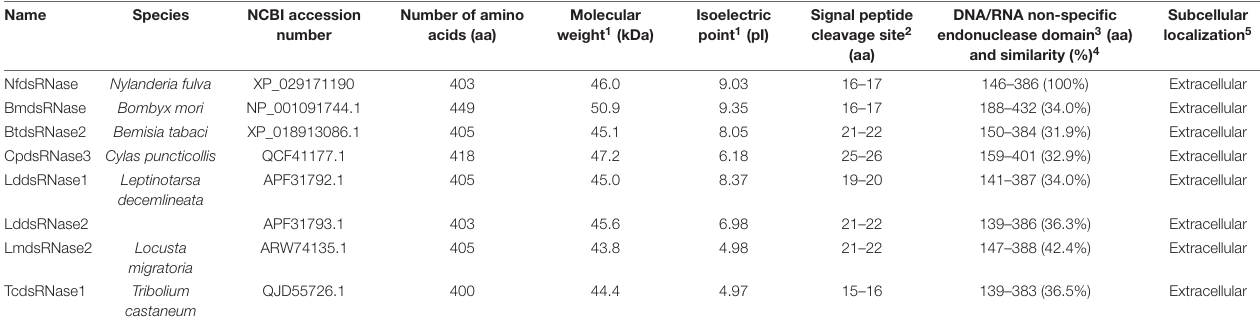
TABLE 3 | Characterization of NfdsRNase and seven previously reported insect